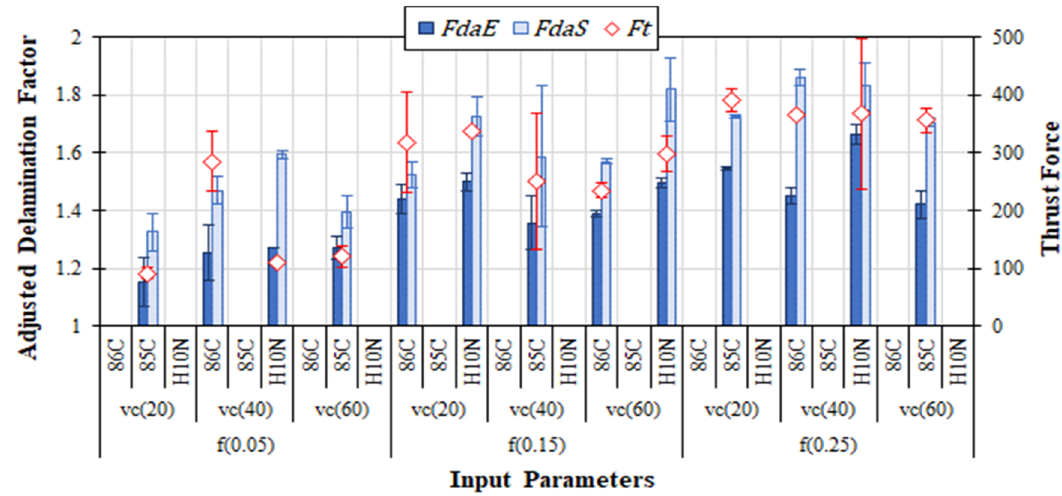
Figure 3: Adjusted delamination factor in the entrance and exit of the GFRP and thrust force.